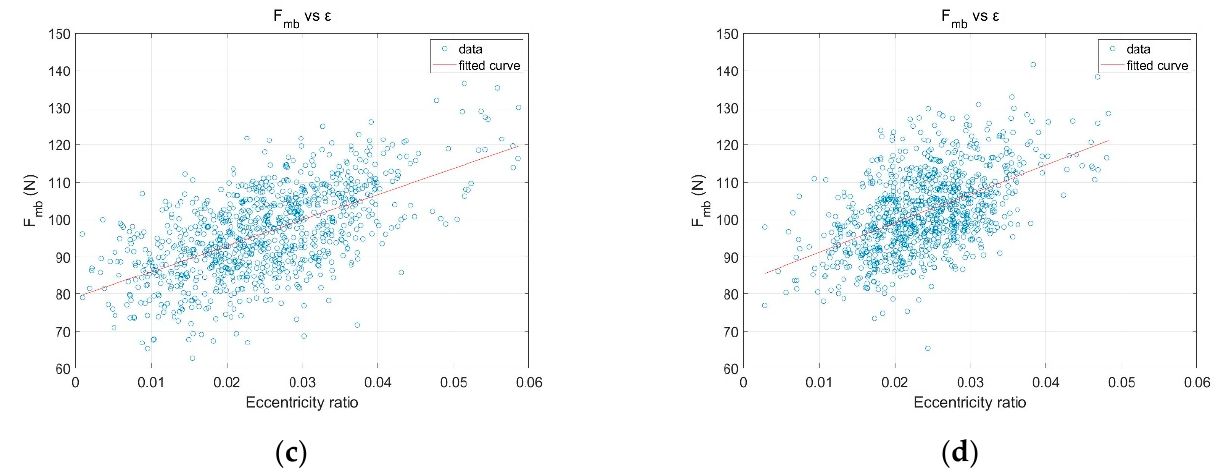
Figure 22. F MB distribution vs. ε from the 30,000 rpm S-CO 2 test 1 ( a ), test 2 ( b ), test 3 ( c ), and test 4 ( d